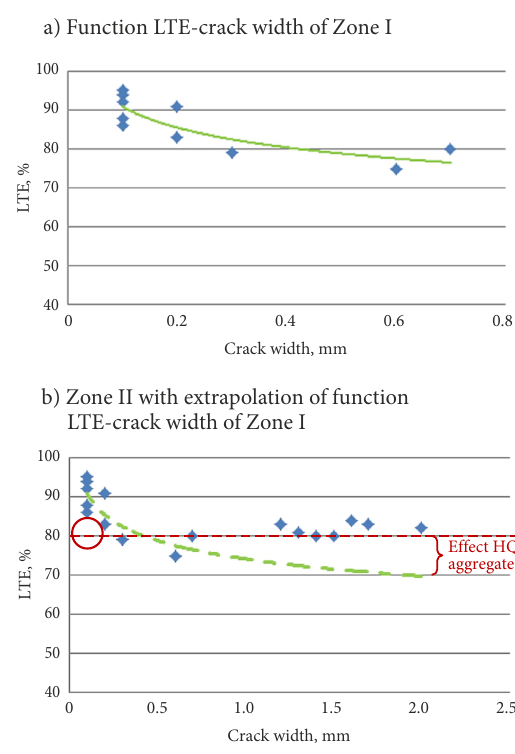
Figure 5. Effect of the high-quality aggregates on the LTE